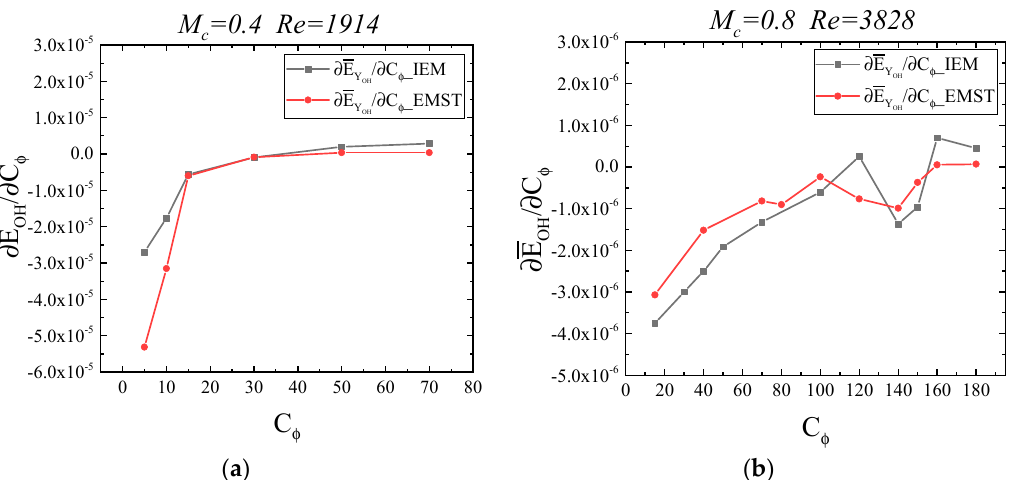
Figure 18. Sensitivity of mean deviation of OH mass fraction against mixing model coefficient obtained using IEM and EMST for ( a ) M c = 0.4 case and ( b ) M c = 0.8 case, respectively.